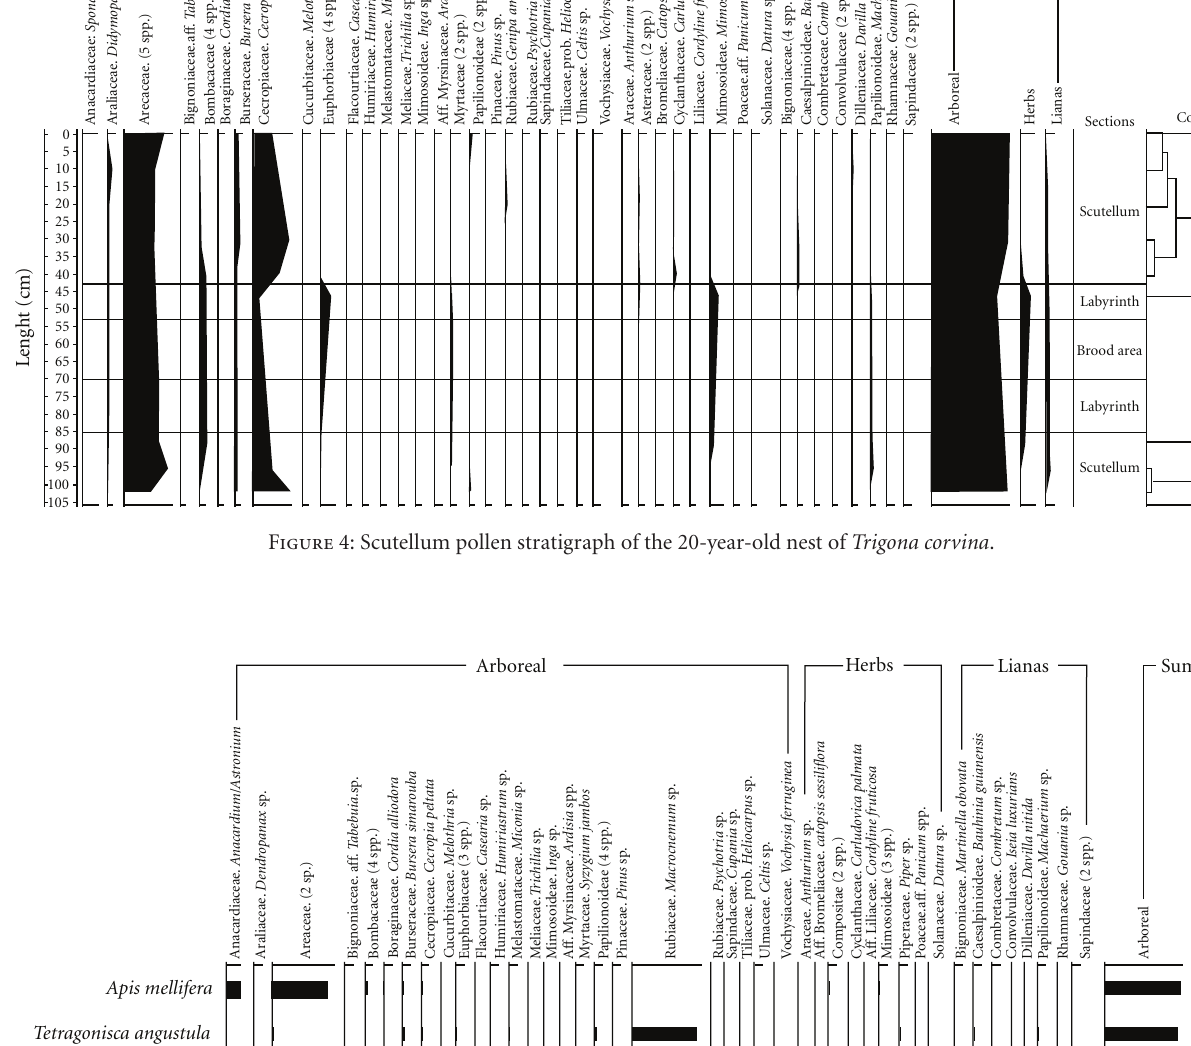
angustulaApis mellifera Tetragonisca Figure 5: Pollen graph for a honey sample analyzed from the study area in mid 2002, from a resident colony of Africanized honey bees and from an abundant native stingless bee, Tetragonisca angustula